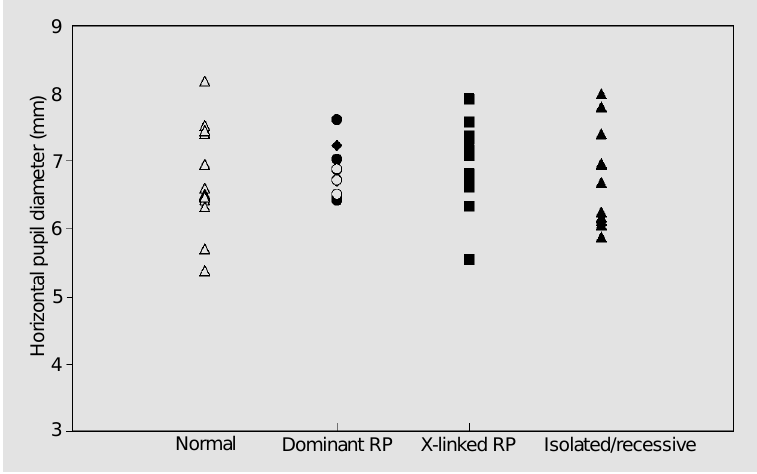
Figure 2. Pupil diameters (mm) measured from 15 normal controls (open triangles) and 3 groups of retinitis pigmentosa (RP) patients (dominant (filled circles, N = 11), X-linked (squares, N = 12), and isolated/recessive (filled triangles, N = 12)) after 45 min of dark adaptation. Dominant rhodopsin (lozenges, N = 4) and slow retinal degeneration (RDS)/ peripherin mutations (open circles, N = 3)